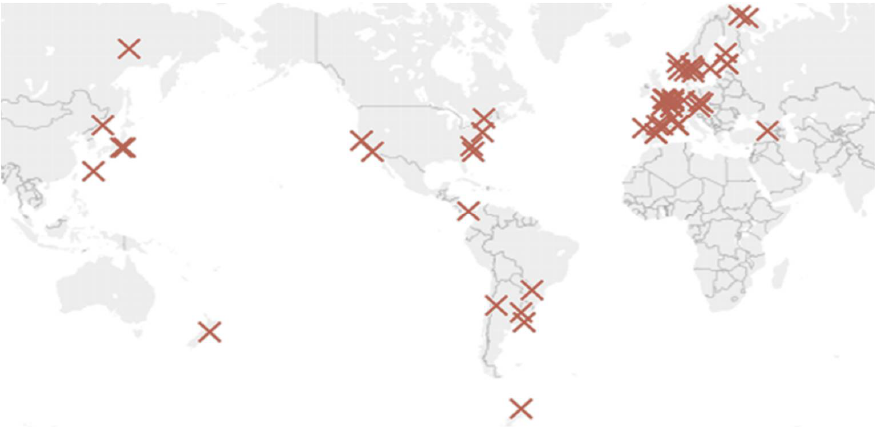
Figure 1. ISOCORRAG program sample’s location.